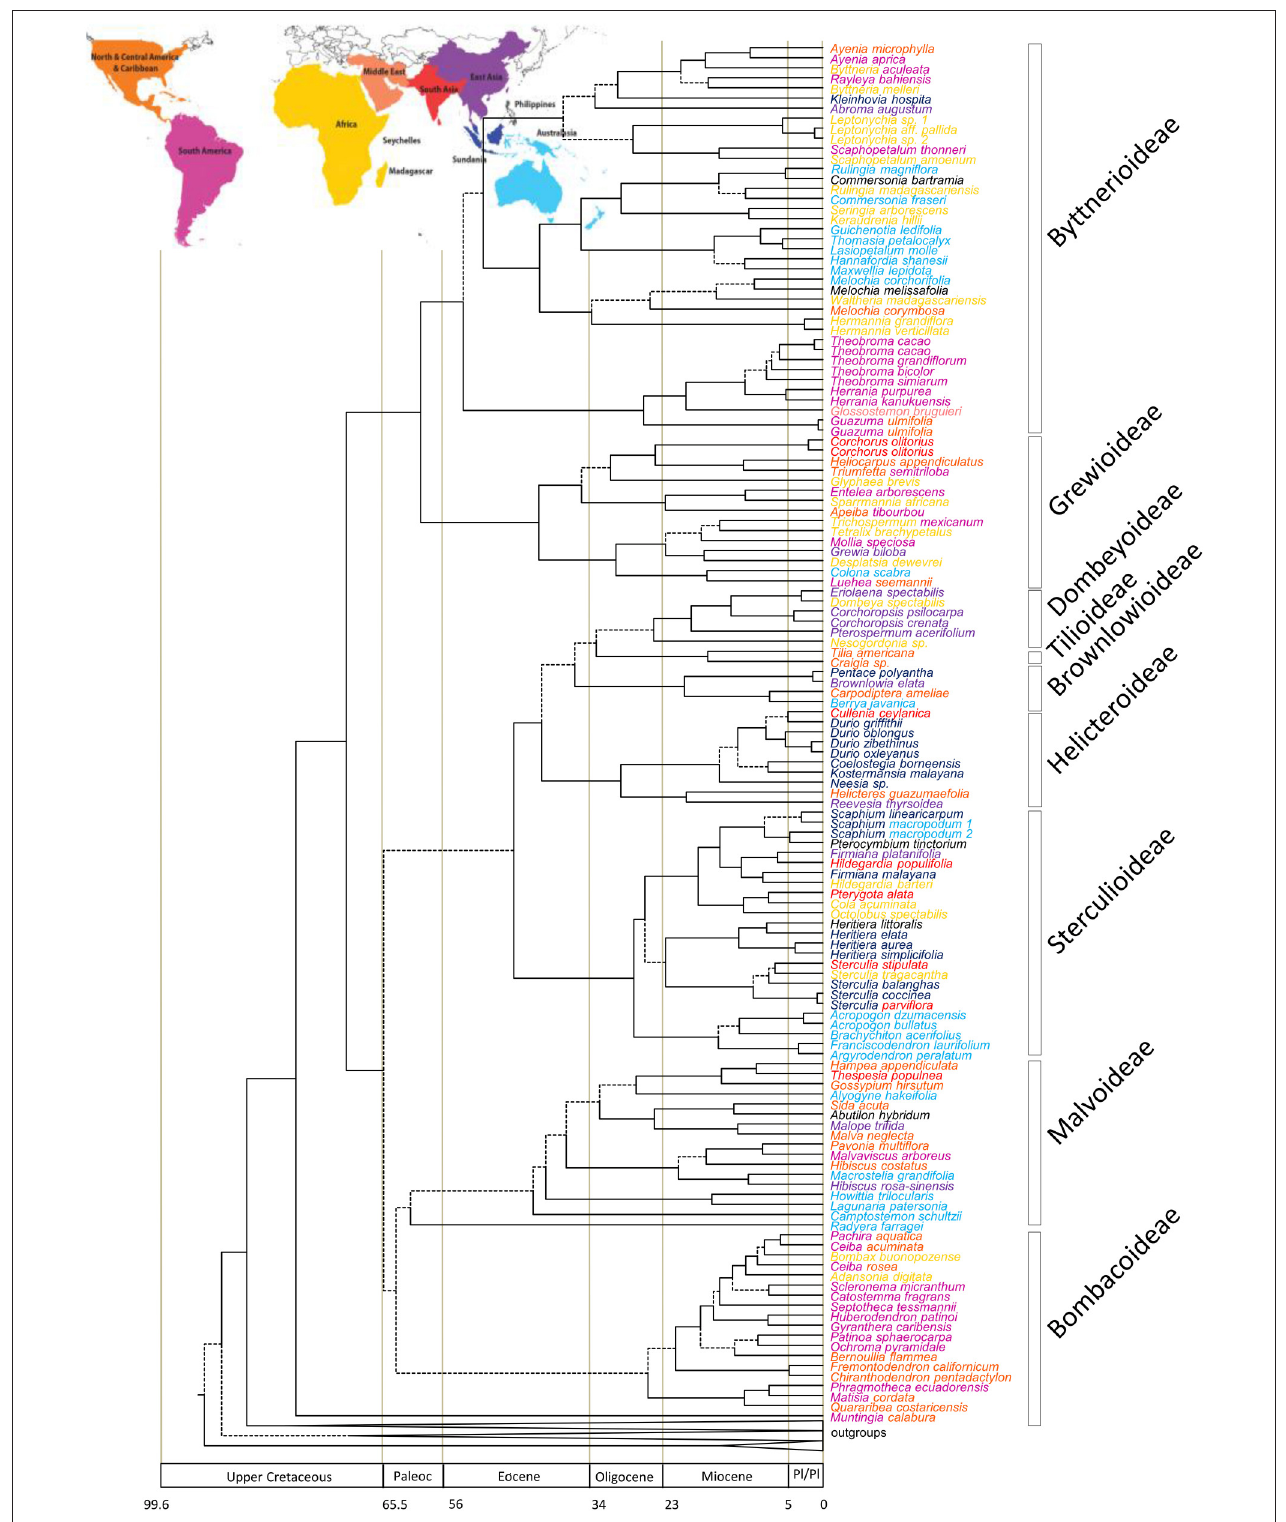
FIGURE 2 | Maximum clade credibility tree resulting from the BEAST analysis of the ndh F data. Broken lines represent branches with < 0.95 pp -values. Names color coded according to the map at top of this figure. If the species is found in two areas the genus name and specific epithet are colored to match the two